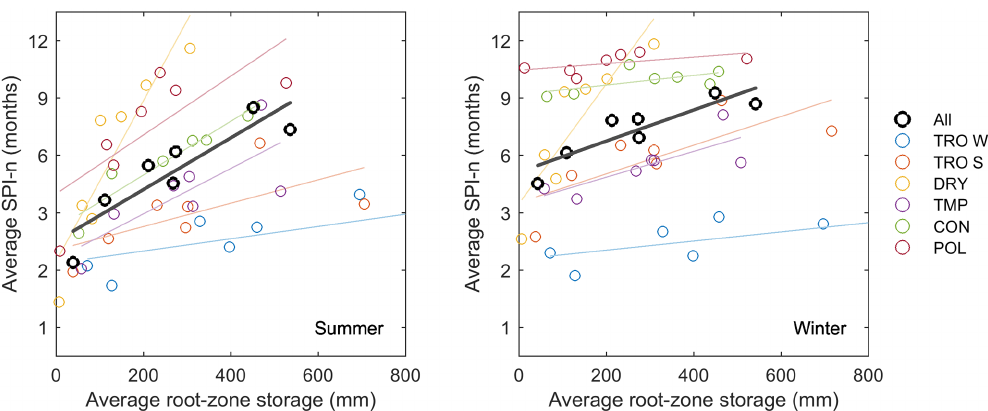
Figure 6. SPI-n for the SSMI averaged over all pixels and each climate type separately plotted against mean annual root-zone soil moisture storage averaged over the same region. Each point represents a model. Lines of best fit have been added for